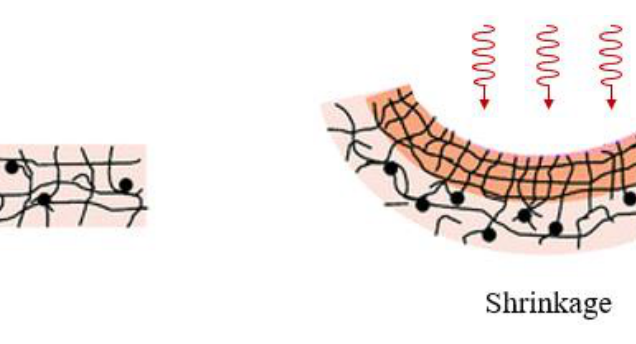
Figure 9. Schematic representation of warping due to volumetric shrinkage. Adapted from [73].